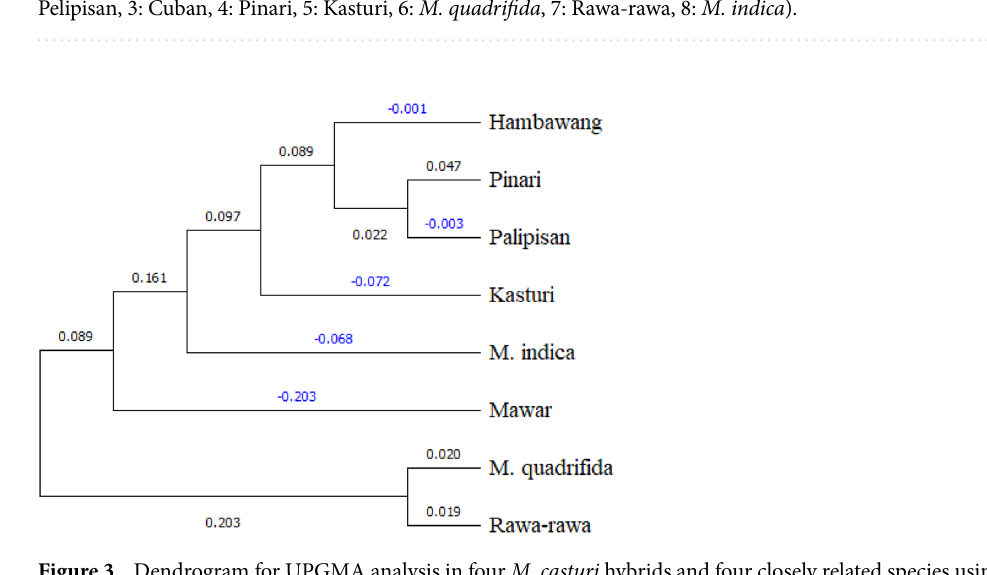
Figure 2. Principal Coordinates Analysis (PCoA) via covariance matrix with data standardization in four M. casturi hybrids and three closely related species using 14 microsatellite loci (1: Hambawang ( M. foetida ), 2: